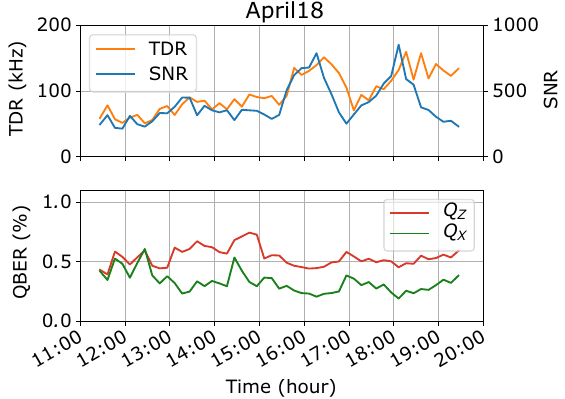
Fig. 2 TDR, SNR and QBER obtained on April 18th, 2019. The TDR averages at around 100 kHz, the SNR is about 400, and the QBER is always <0.75% for the eight